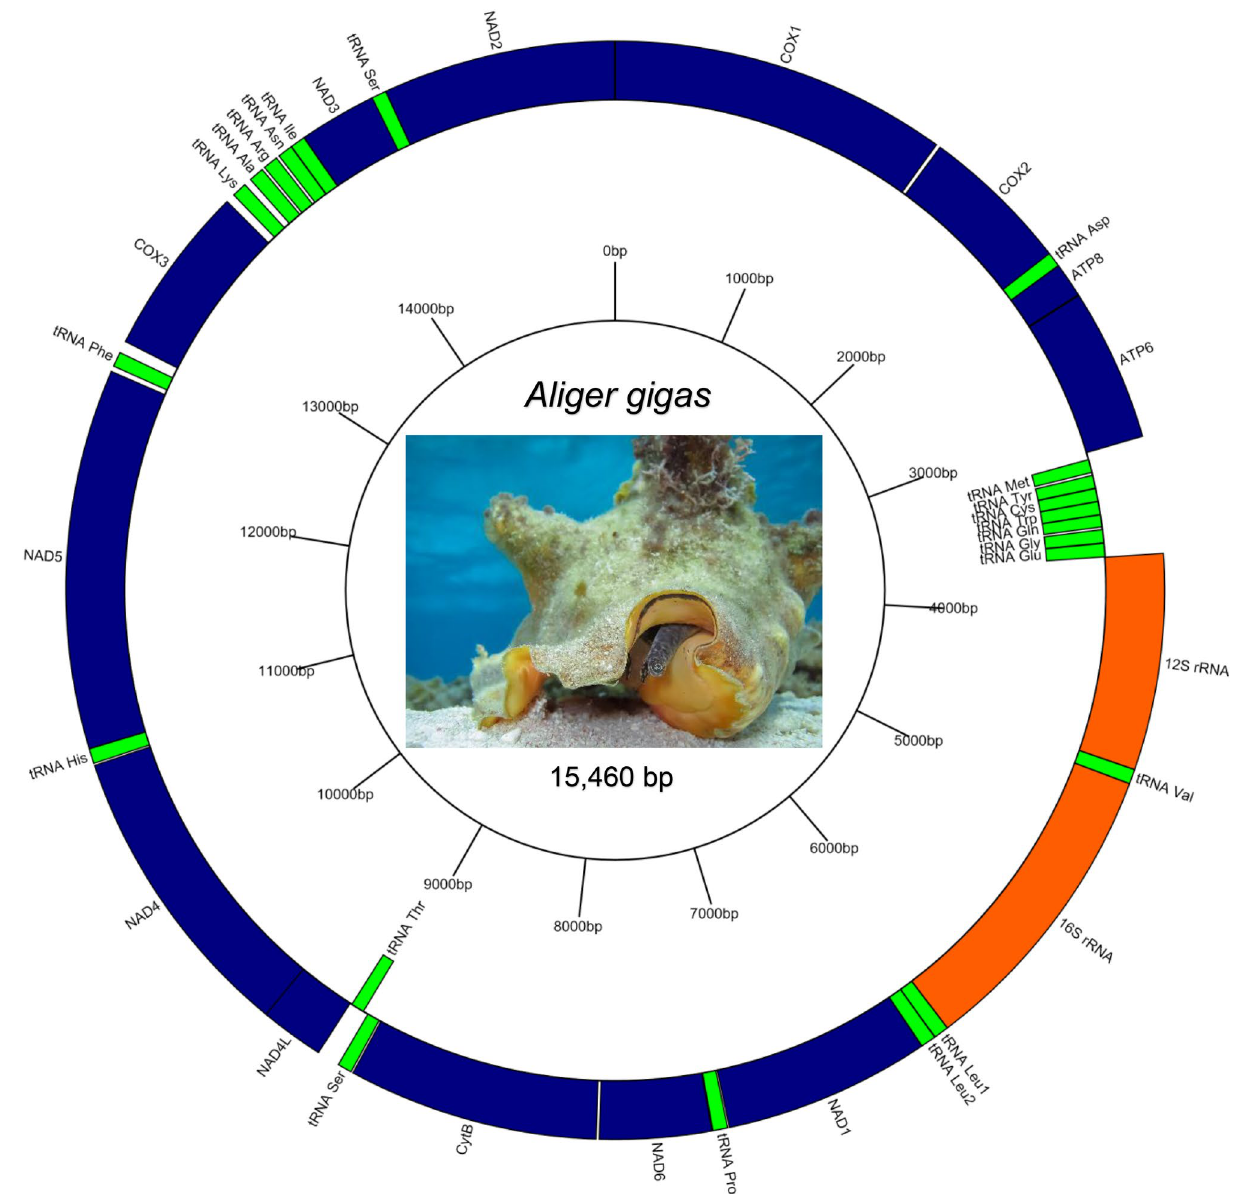
Figure 1. Mitochondrial genome map of Aliger gigas (GenBank MZ157283). All 37 genes are represented outside of the circle (direction 5’ → 3’) and to the inside (direction 3’ → 5’) in order and relative size and including non-coding regions. Protein coding genes (blue), transfer RNAs (green) are identified using the three letters corresponding to their amino acid, and ribosomal RNAs (orange) are presented. Photo by: HBahena/